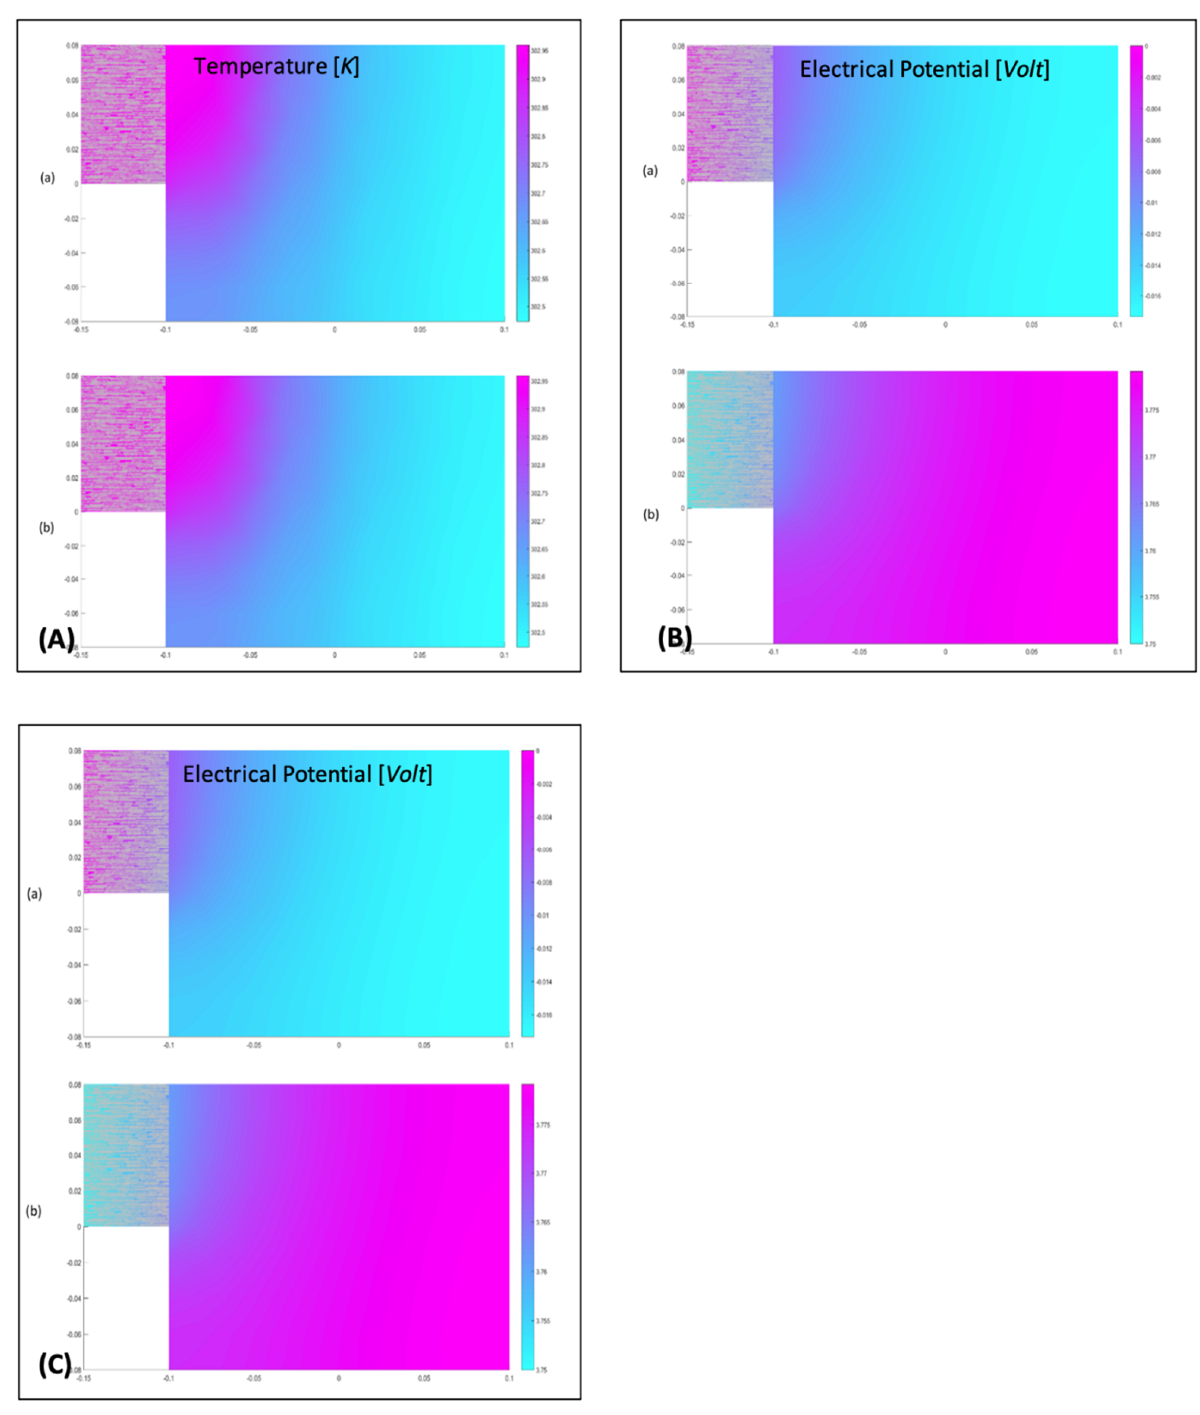
Figure 11. 2D results of temperature and electrical potential for the second simulation group . The scales show the cell dimensions as in Figure 1 (Unit: m). Color distribution as noted below. ( A ) The temperature distribution of a cell shows unevenness. Areas near collector tabs indicate higher temperatures. ( a ) GPR-based model. ( b ) Result using [16]. ( a , b ) results are identical. Color scale index cell temperature in K. ( B ) GPR model-based electrical potential distribution on the ( a ) negative plate and ( b ) positive plate. Potential is relatively higher in ( a ) and lower in ( b ) near the current collector tab area. Color scales index the electrical potentials in Volts. ( C ) Electrical potential distribution at the 25th s. using [16], which correspond to the results by our GPR models in the first simulation group as in Figure 11B. Electrical potential distribution on the ( a ) negative plate, and ( b ) positive plate of the cell in 2D. They are identical to the results in Figure 11B. Color scales index the electrical potentials in Volts . Scales indicate cell dimensions (Unit: m).